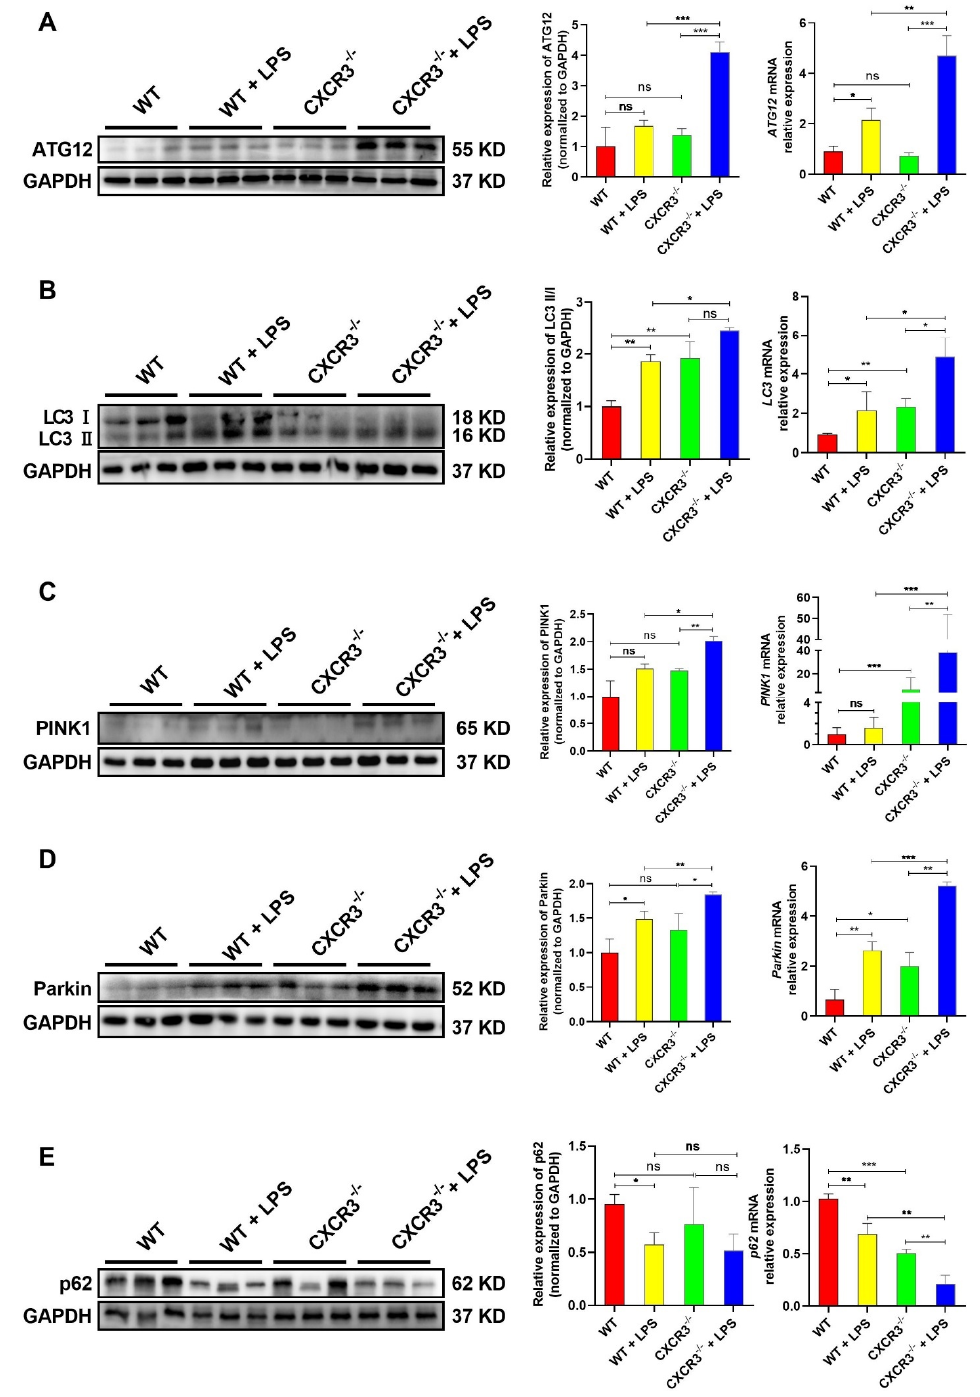
Figure 2. CXCR3 knockout promotes autophagy in the mouse intestine. C57BL/6J WT mice and CXCR3 − / − mice were intraperitoneally injected with LPS 10 mg/kg. After 24 h, the mice were sacrificed, and the intestine was collected. The mRNA and protein of jejunum tissue were extracted. qPCR and Western Blot assays were conducted to investigate the mRNA and protein expression of autophagy-related genes. ( A ) ATG12 mRNA and protein expression. ( B ) LC3 mRNA and protein expression. ( C ) PINK1 mRNA and protein expression. ( D ) Parkin mRNA and protein expression. ( E ) p62 mRNA and protein expression. The protein optical density values were analyzed by Image J software. Values represent the mean ± SEM. of three independent experiments. Significant differences are represented by * p < 0.05, ** p < 0.01, *** p < 0.001, and ns (not